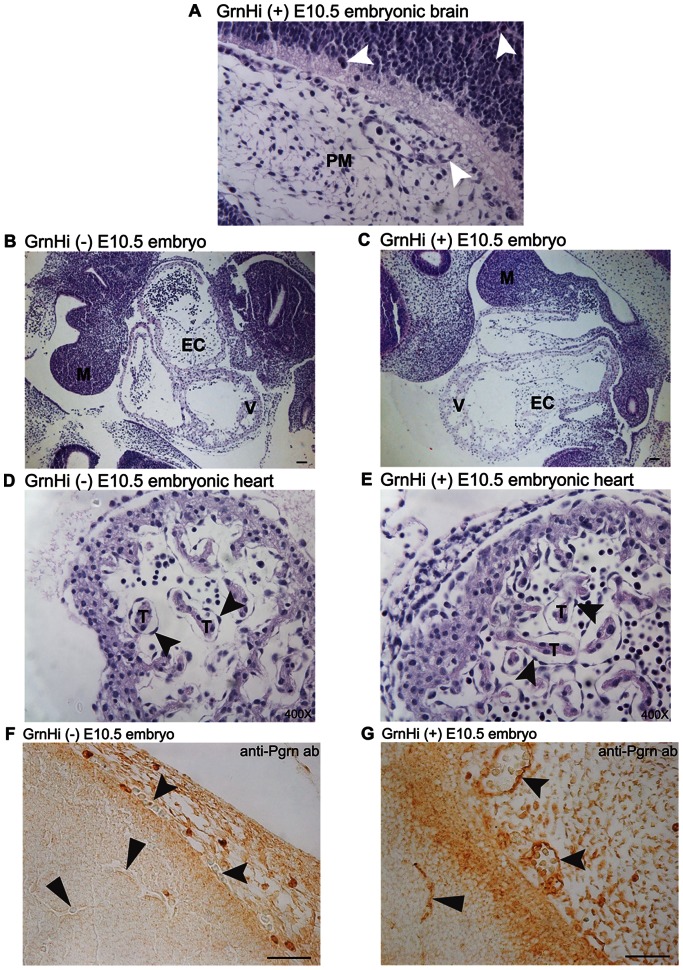
The development of the vasculature and heart appears normal at mid- gestational Tie2-Grn positive embryos (E10.5).(A) Sprouting capillaries (white arrow heads) in the brain and meninges of a Tie2-Grn positive embryo (PM, pia mater). (B) and (C) illustrate the appearance of the heart in a Tie2-Grn negative (B) and Tie2-Grn positive embryo (C), which are structurally similar. EC, endothelial cushion. (D–E) Trabeculation and the formation of the endothelial lining of the trabeculae are indistinguishable in a Tie2-Grn negative (D) and Tie2-Grn positive embryo (E) embryos. (Black arrow heads point to the endothelium covering the cardiac muscle of the trabeculae). A Tie2-Grn negative (F) and Tie2-Grn positive embryo (G) stained for progranulin demonstrate the increased production of progranulin in the endothelia (black arrow heads) of the Tie2-Grn positive embryo at E10.5. M, mandible; EC, endocardial cushion; T, trabeculae. Scale bars denote 20 µm. Images were obtained from the GrnHi line.